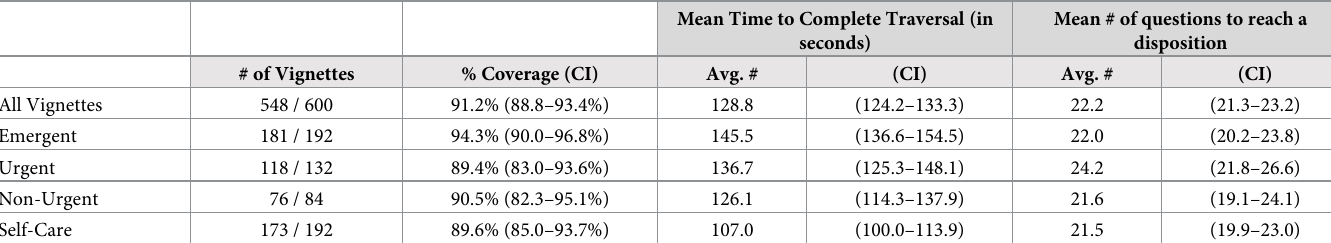
Table 1. Vignette coverage, mean time to complete and number of questions asked to reach a disposition.